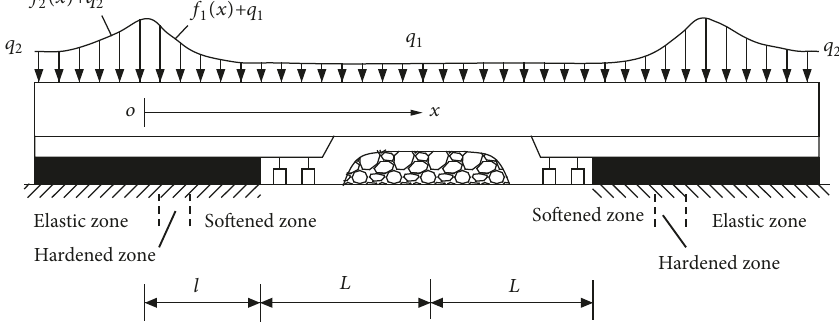
Figure 3: Surrounding rock constitution and load state of hard roof before first breaking.